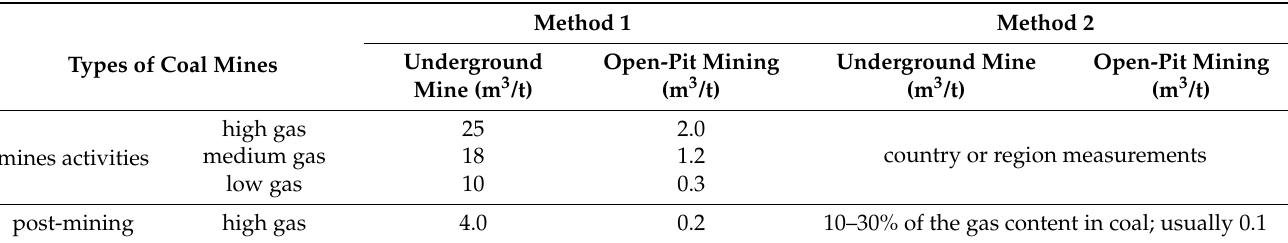
Table 1. Methane emission factors for coal mining